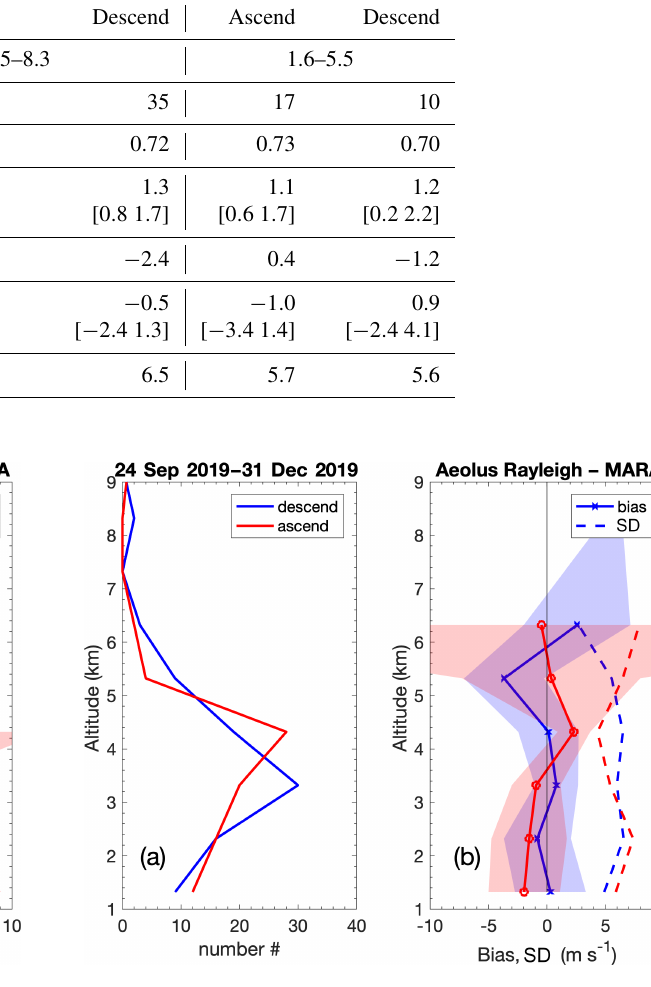
Figure 4. Height profiles in 1km bins of (a) the number of com- parison points available and (b) mean value (bias) and standard de- viation of the differences between Aeolus Rayleigh HLOS winds and MARA-derived HLOS winds for the Antarctic winter period 1 July–23 September 2019. Red lines and shading are for ascending tracks and blue is for descending ones. Solid lines in (b) show the bias, with the shaded areas corresponding to the 90% confidence interval. Dashed lines in (b) show the standard deviation.